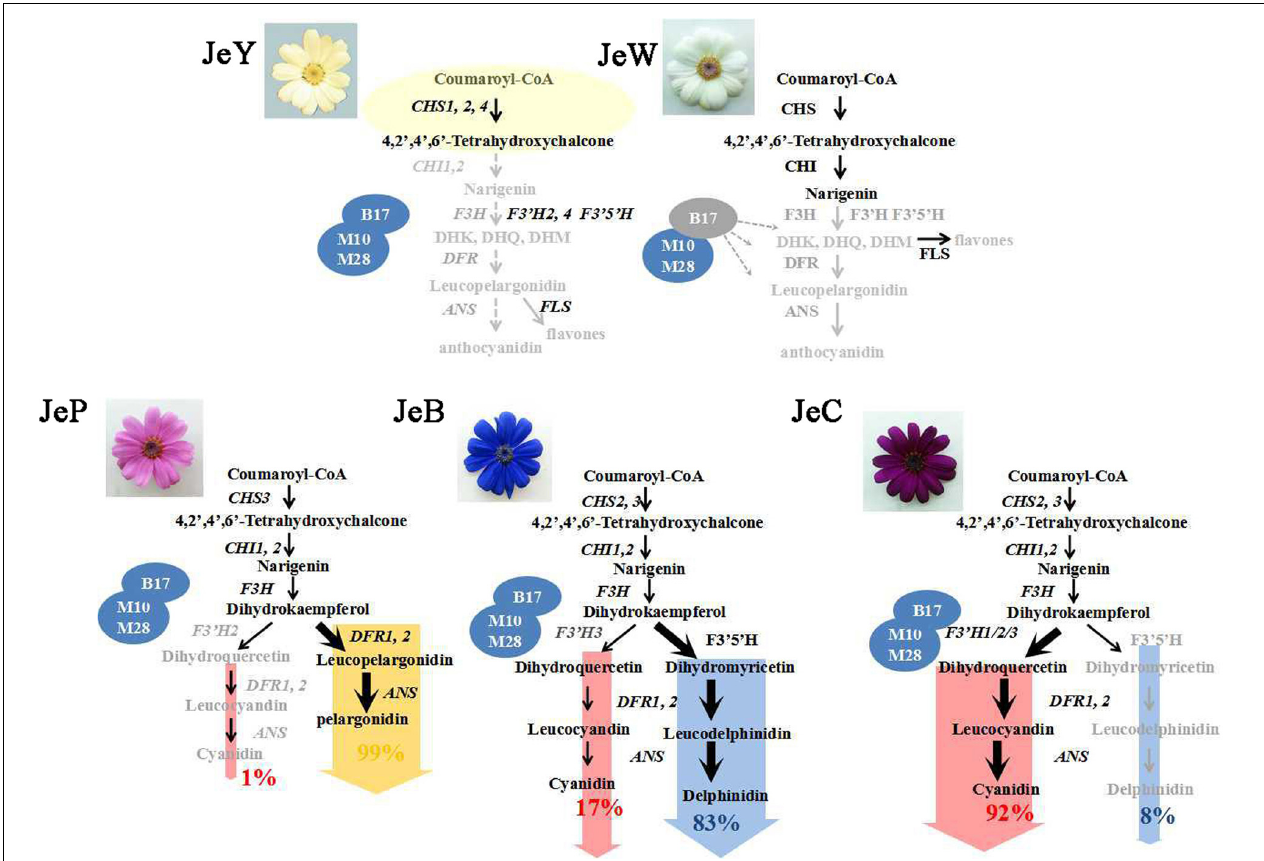
FIGURE 7 | Conclusive pathways for S. cruentus flower